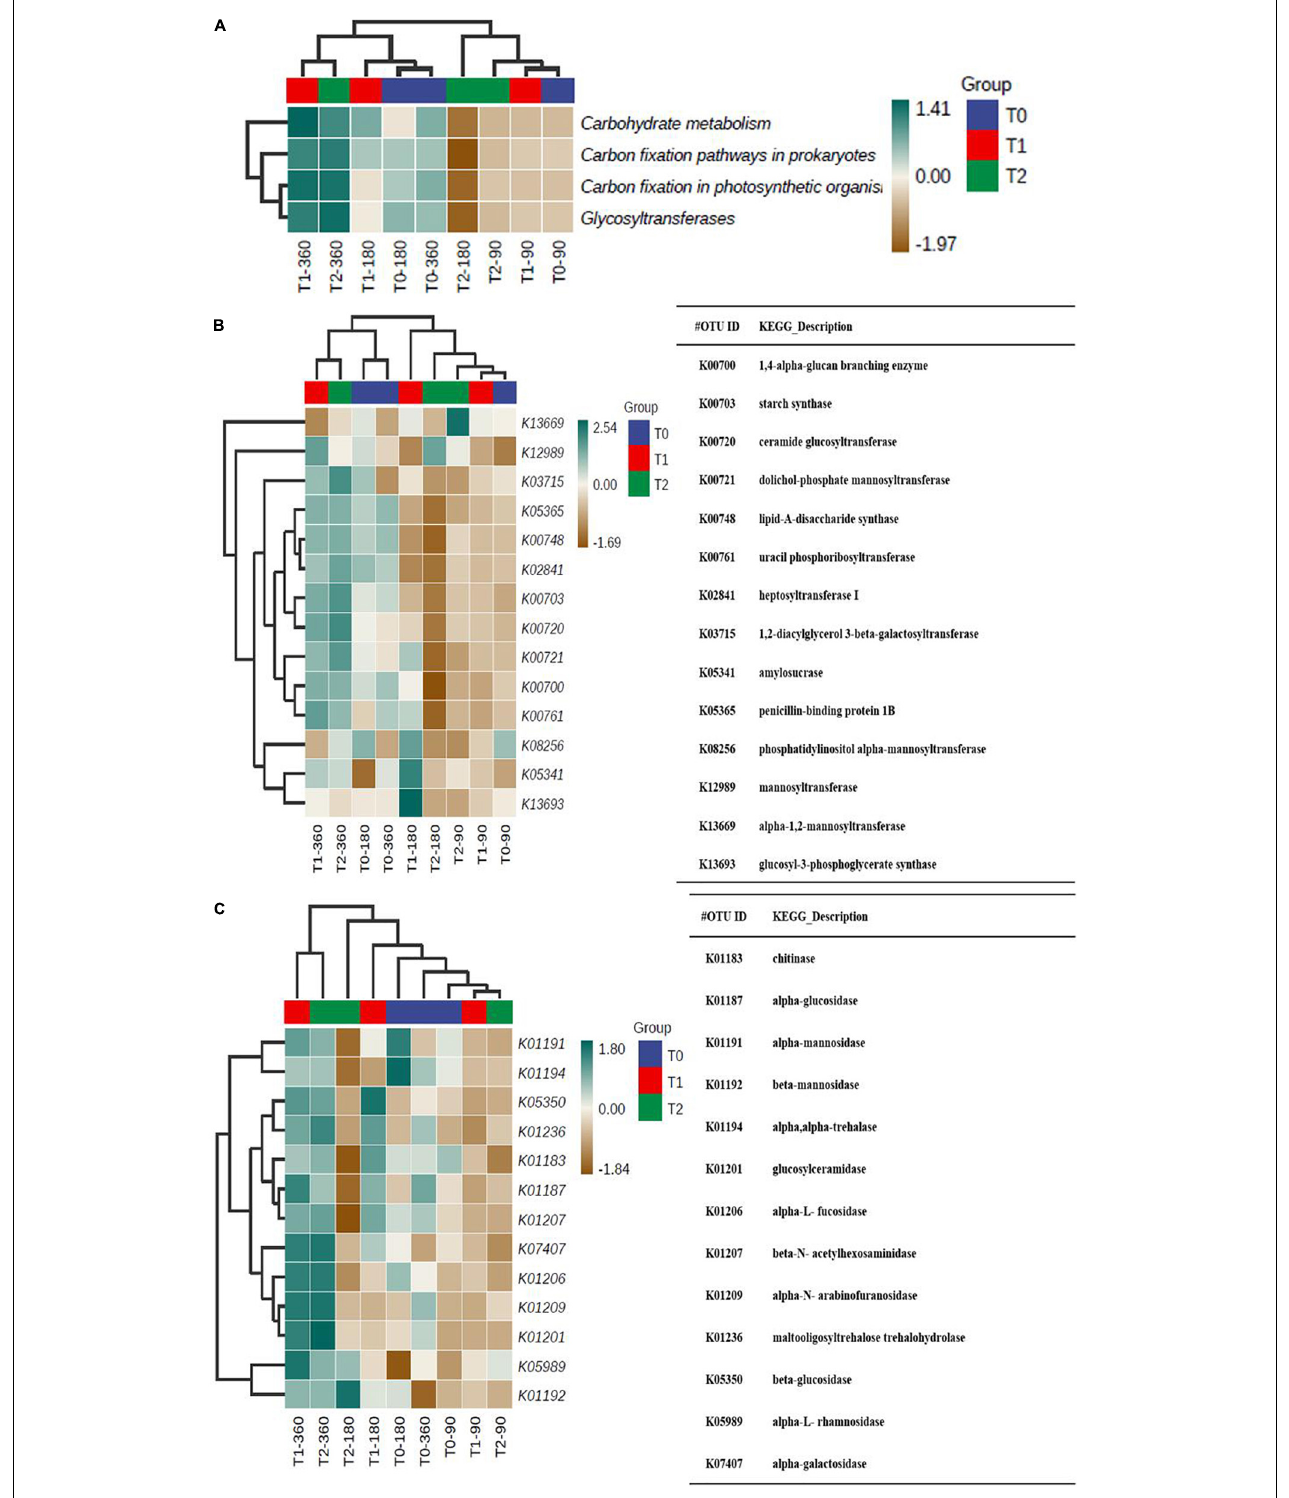
FIGURE 7 | (A) The predicted C cycle-related functions in the microbial communities in the tailing sand samples and the predicted C cycle (B) biosynthesis and (C) catabolism profiles. T0, iron tailing sand + soil; T1, iron tailing sand + soil + Pennisetum giganteum ; T2, iron tailing sand + soil + bio-matrix pot + Pennisetum giganteum . 90 d, 180 d, and 360 d indicate the sampling time in days after the start of the experiment.